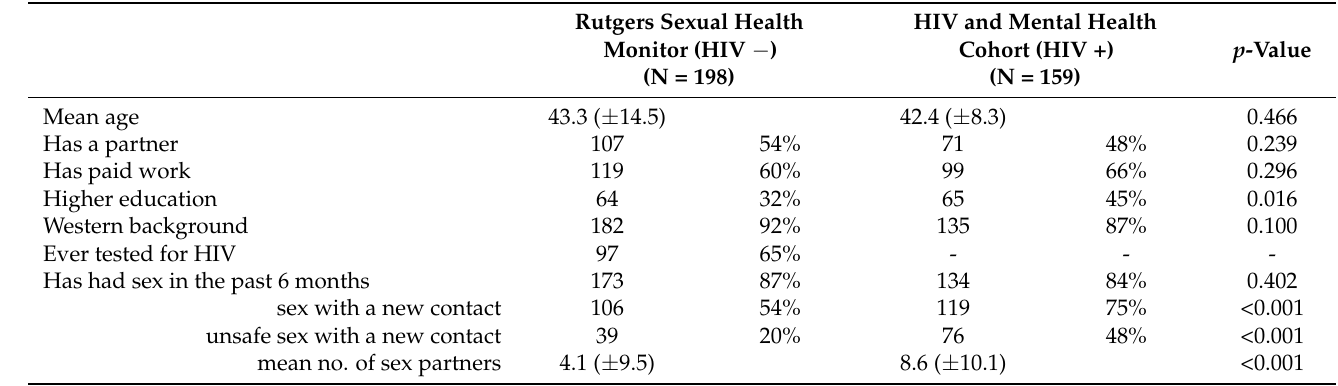
Table 1. Comparison between MSM from the general population (Rutgers Sexual Health Monitor) and from the study on HIV and Mental